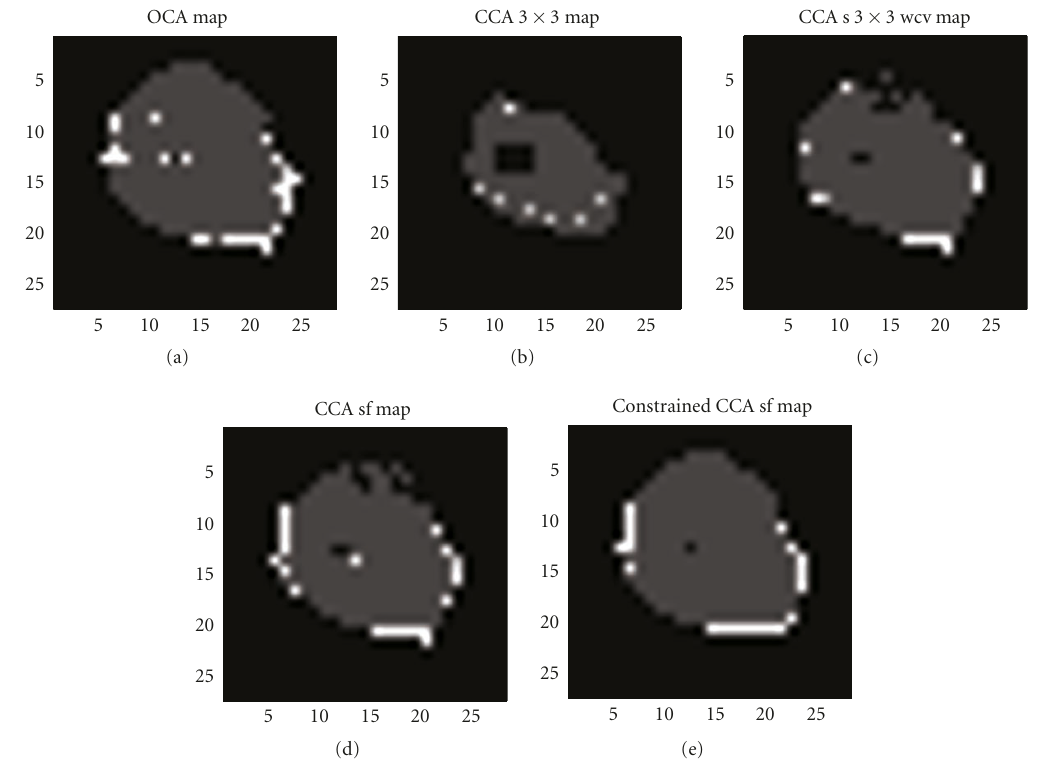
Figure 5: Nosologic images obtained from di ff raction data of Figure 1 by CCA when applying di ff erent spatial models (see the text for